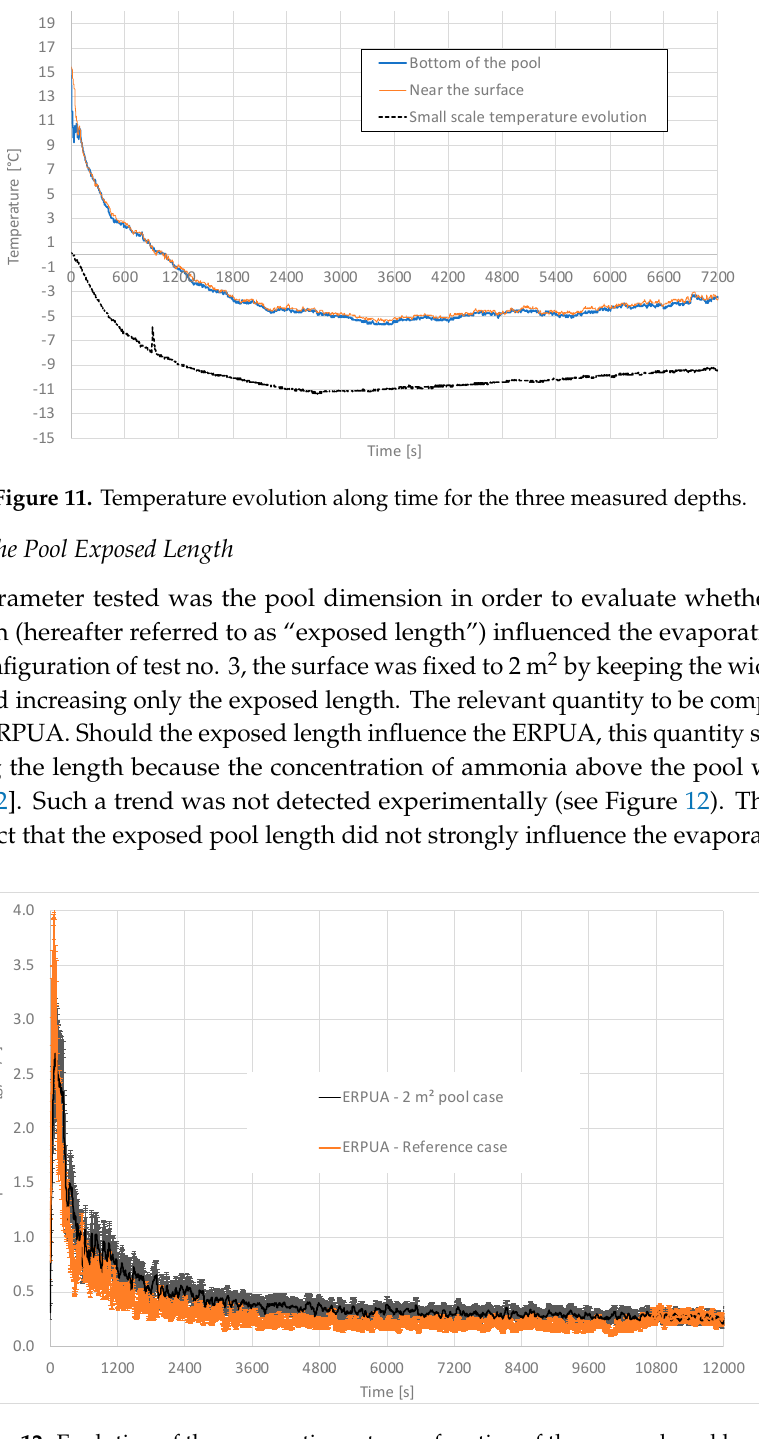
Figure 12. Evolution of the evaporation rate as a function of the exposed pool length.